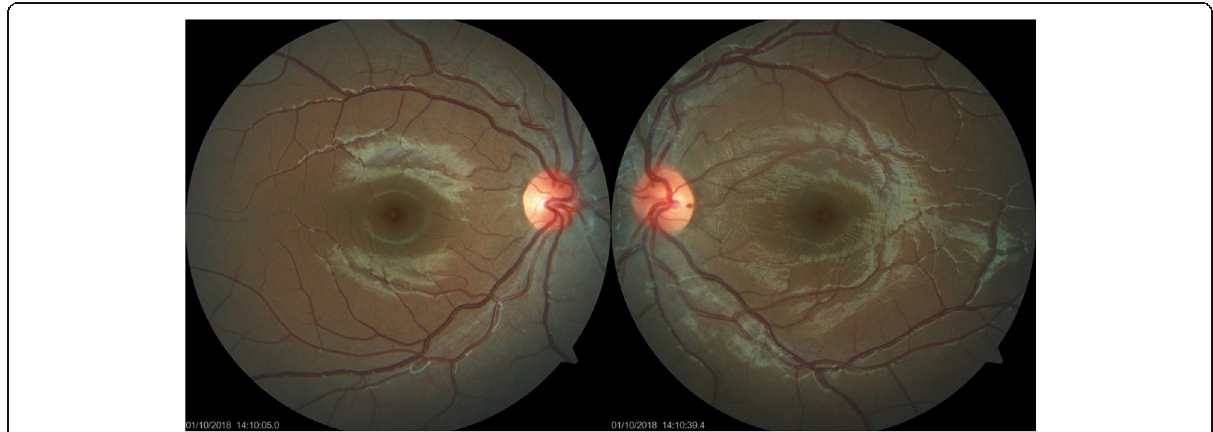
Fig. 4 Final follow-up at 15 months: normal fundus photograph of both